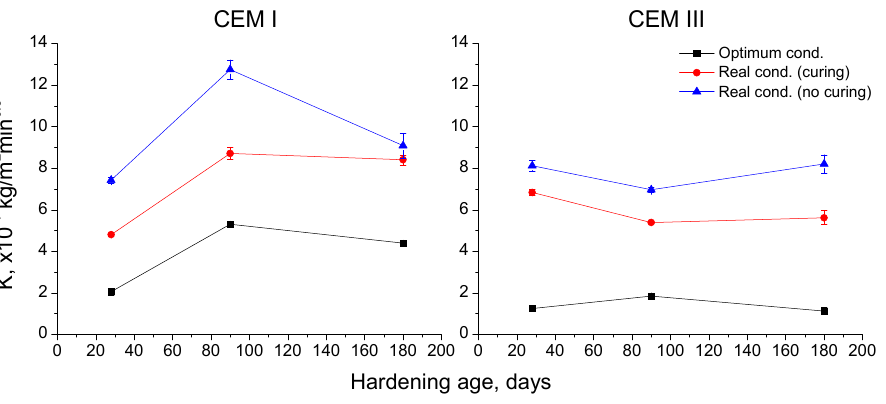
Figure 7. Results of capillary suction coefficient (K) for CEM I and CEM III concrete samples.